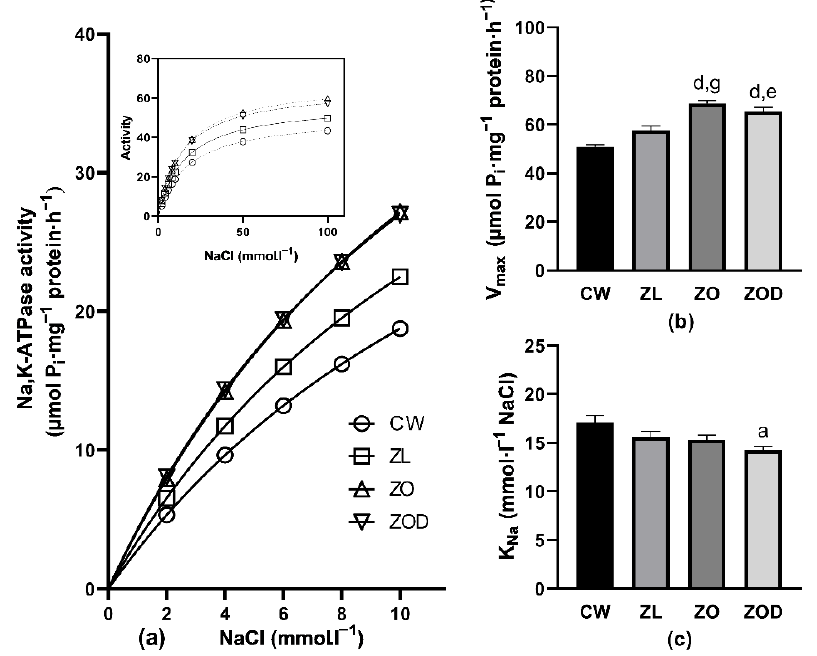
Figure 1. Activation of the Na,K-ATPase enzyme by cofactor Na + in the renal cortex. (Panel a ) Activation of the Na,K-ATPase by low concentrations of cofactor Na+. Inset: activation of the enzyme in the whole investigated concentration range of Na + in Wistar rats (CW, n = 8), lean fa/+ (ZL, n = 8), and Zucker diabetic fatty (ZDF) fa/fa rats divided into ZO (ZDF fa/fa obese, glycemia < 10 mmol · L − 1 , n = 8) and ZOD (ZDF fa/fa obese diabetic, glycemia > 10 mmol · L − 1 , n = 8) groups. Error bars are not depicted, as they are shorter than the size of the symbols. (Panel b ) V max values in all experimental groups. (Panel c ) K Na values in all experimental groups. The animals were sacrificed at the age of 38–39 weeks. Data represent means ± standard errors of mean. For statistical analyses, one-way analysis of variance with Tukey’s post hoc test was used: a: p < 0.05, b: p < 0.01, d: p < 0.0001 vs. CW; e: p < 0.05, g: p < 0.001 vs. ZL.